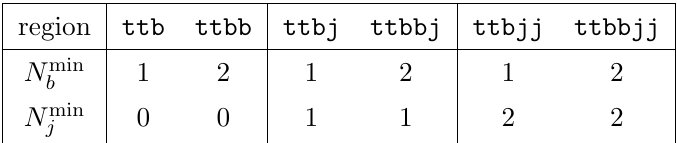
Table 2. Naming scheme for phase-space regions with di(cid:11)erent inclusive multiplicities of b -jets ( N b N min ) and light jets ( N j b (cid:21)